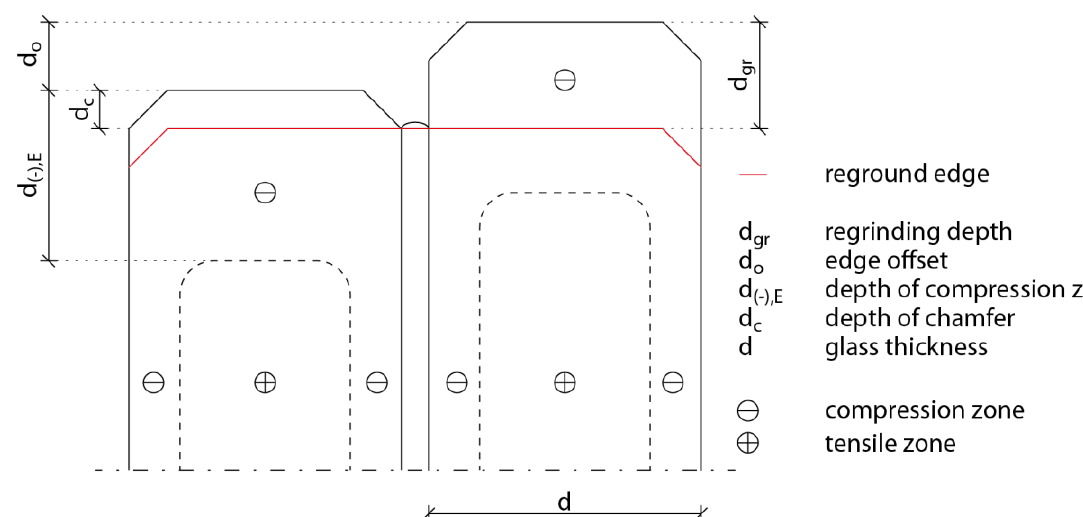
Fig. 2 Detail of an edge offset in a laminated glass including the residual stress distribution of the single glass